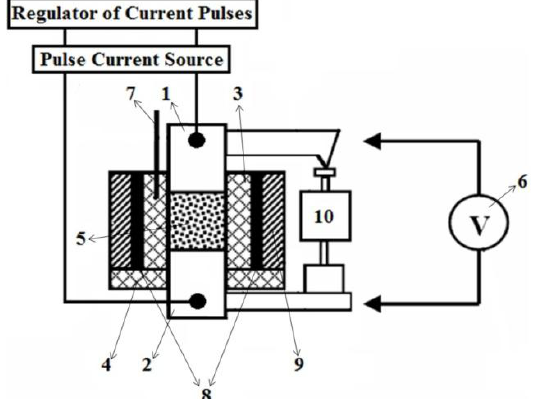
—rheocord; R , 1 2 , O , O —oscilloscope 1 2 3